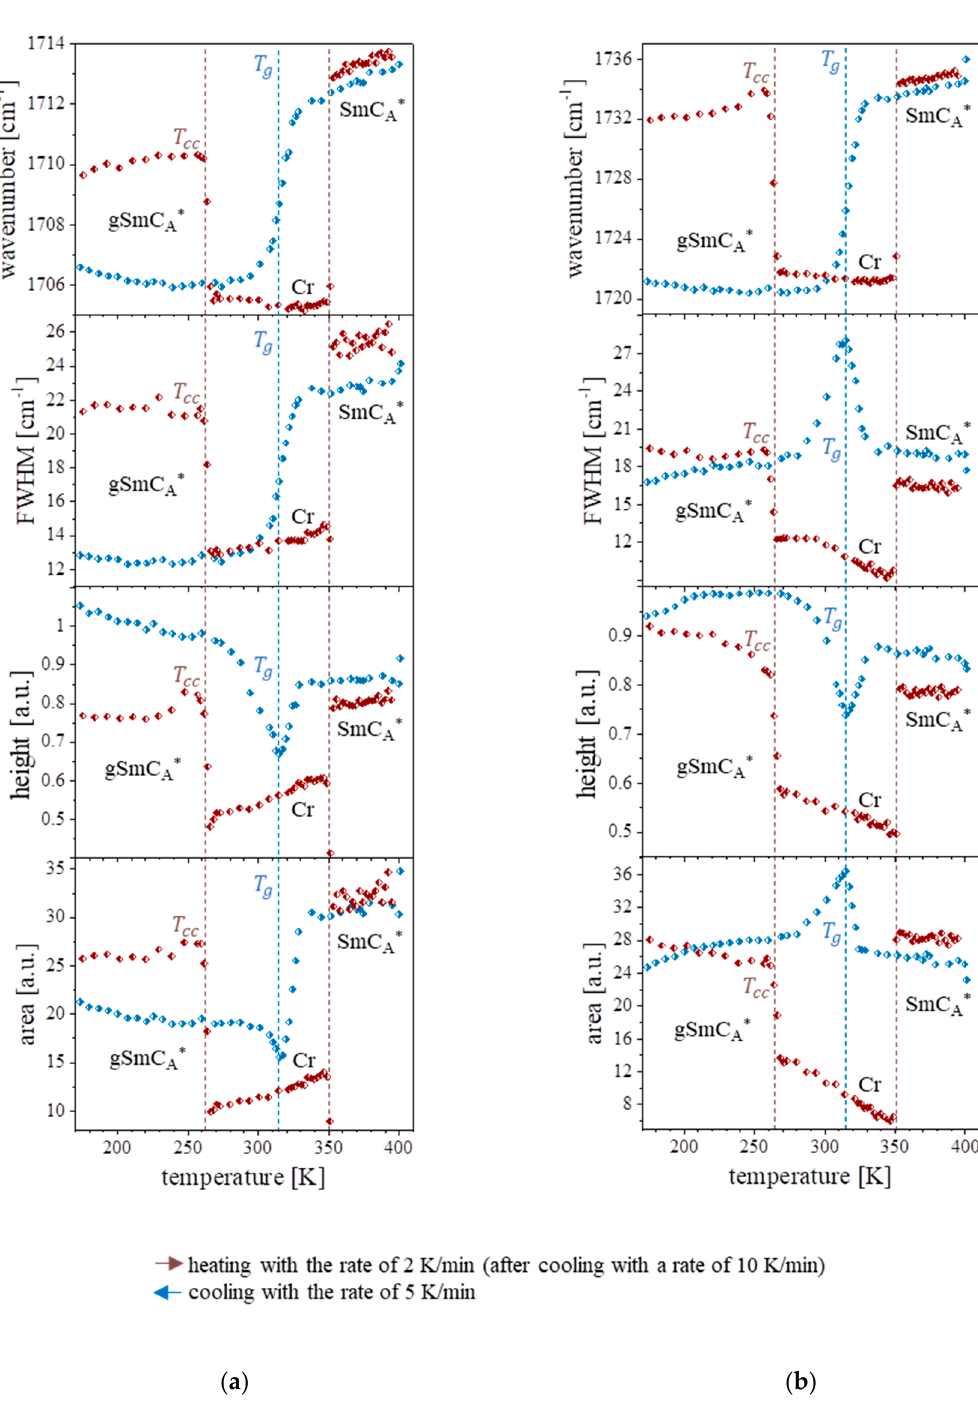
Figure 13. Temperature dependence of wavenumbers, FWHM’s, areas and heights of the bands associated with stretching vibrations of: ( a ) (C=O) chiral_c. and ( b ) (C=O) core registered during cooling (blue) with the rate of 5 K/min and heating (red) with the rate of 2 K/min (after previous fast cooling with the rate of 10 K/min).